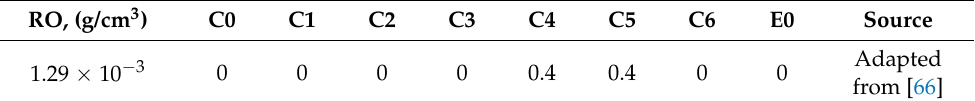
Table 12. Material parameters of the air filling computational domain used in